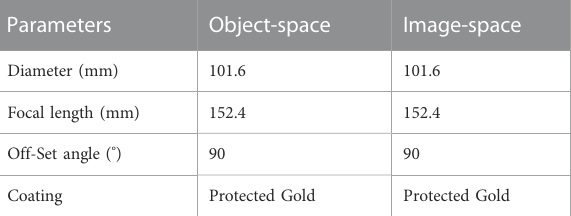
TABLE 1 The speci fi cations of two off-axis parabolic mirrors.